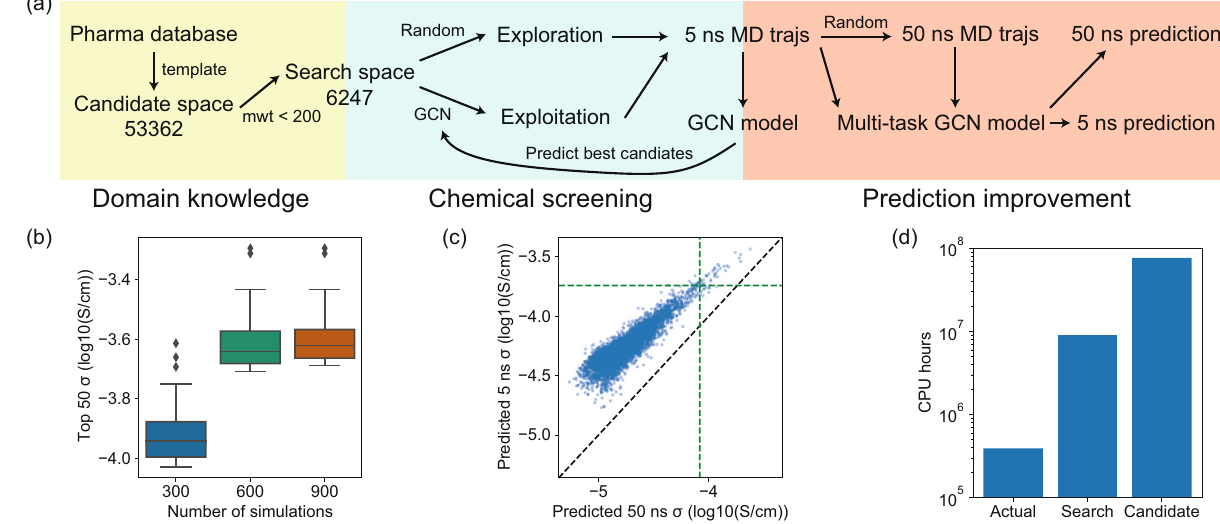
Fig. 4 Screening of polymer electrolytes. a Illustration of the screening work fl ow. b Distribution of the conductivities of top 50 polymers after each iteration, showing the quartiles of conductivity distributions. c Predictions of 50 ns and 5 ns conductivities for 6247 polymers in the search space. Green line denotes the top 50 conductivity from both predictions. d CPU hours that are actually used, required to screen the entire 6247 search space, and required to screen the 53362 candidate space.